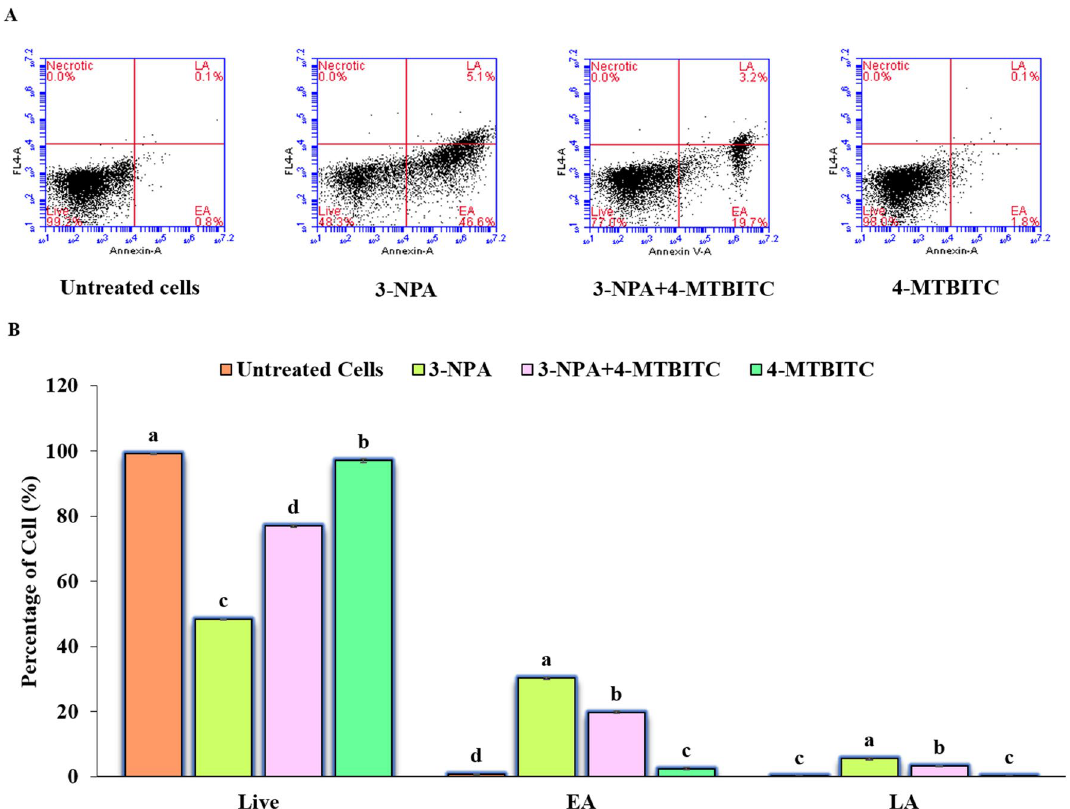
Figure 8. ( A ) Flow cytometric representation of apoptosis by dot plots of double annexin V/FITC-PI staining and flow cytometry in SH-SY5Y cells. Data are presented as the proportion (%) of cells in four different quadrants: live cells (Annexin V and PI negative), early apoptosis (EA = Annexin V-positive, PI negative), late apoptosis (LA = Annexin V-positive, PI positive) and necrotic (Annexin V-negative, PI positive). ( B ) The corresponding bar diagram of flow cytometry results as percentage of apoptosis. Results are expressed as the mean ± SEM of three set of independent experiments. AV, Annexin V.